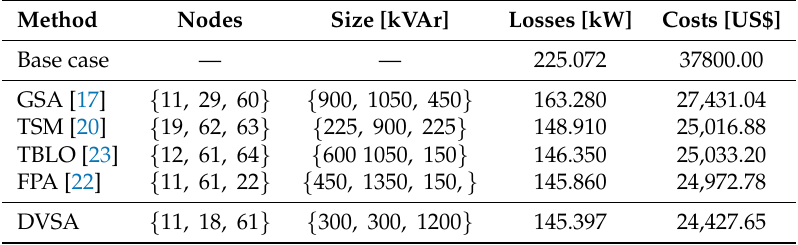
Table 4. Optimal location of capacitor banks in the 69-node test feeder.